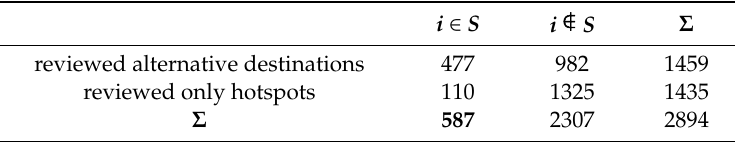
Table 2. Cross-tabulation of Qyer users by their membership in the focus segment S = {i | F i > 0} ∩ {i | R i > 1} and their microblogging behaviour in relation to tourism hotspots.